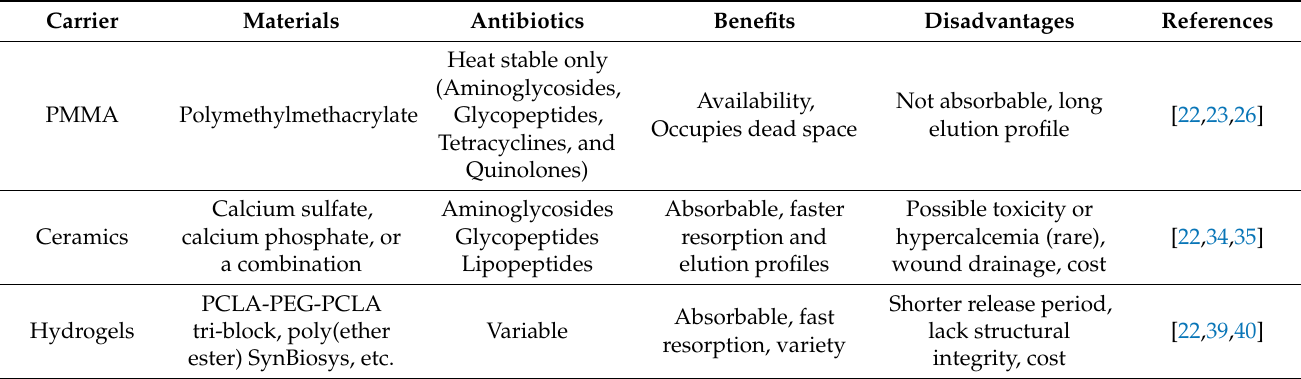
Table 1. Common Antibiotic Carrier